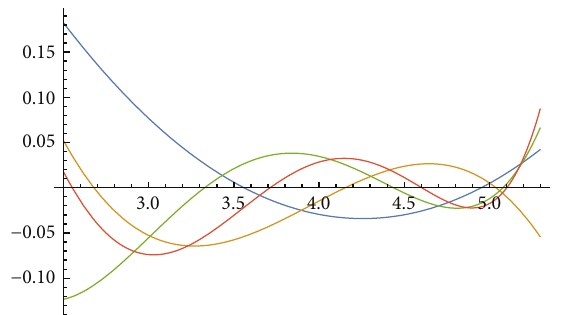
Figure 1: Graphs of the polynomials 𝐺 𝑛,𝛽 (𝜏;𝛼, 𝑁) after the change of variable 𝑥 = 𝜏 𝛽 , for 𝑛 = 2 , 3 , 4 , 5, for the specific values of the parameters 𝛼 = 3 / 5, 𝛽 = 1 / 7, and 𝑁 =